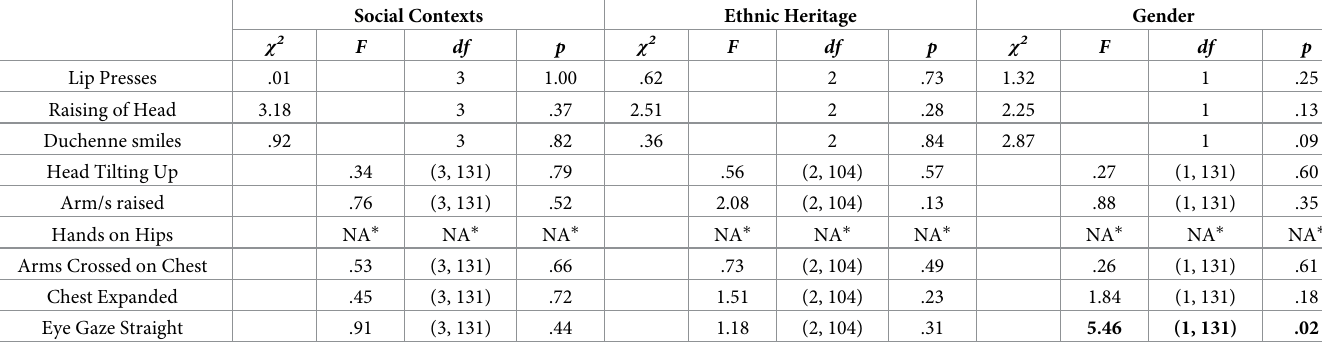
Fig 3. Differences in verbal pride intensity across gender. Error bars show the Standard Error. https://doi.org/10.1371/journal.pone.0285152.g003 Table 3. Statistics on the differences in the nonverbal displays of